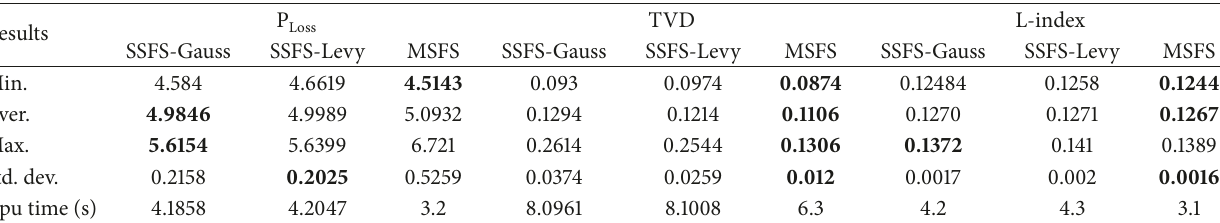
Table 3: Comparisons of result obtained by the proposed method, SSFS-Gauss and SSFS-Levy for different objectives of IEEE 30-bus system.